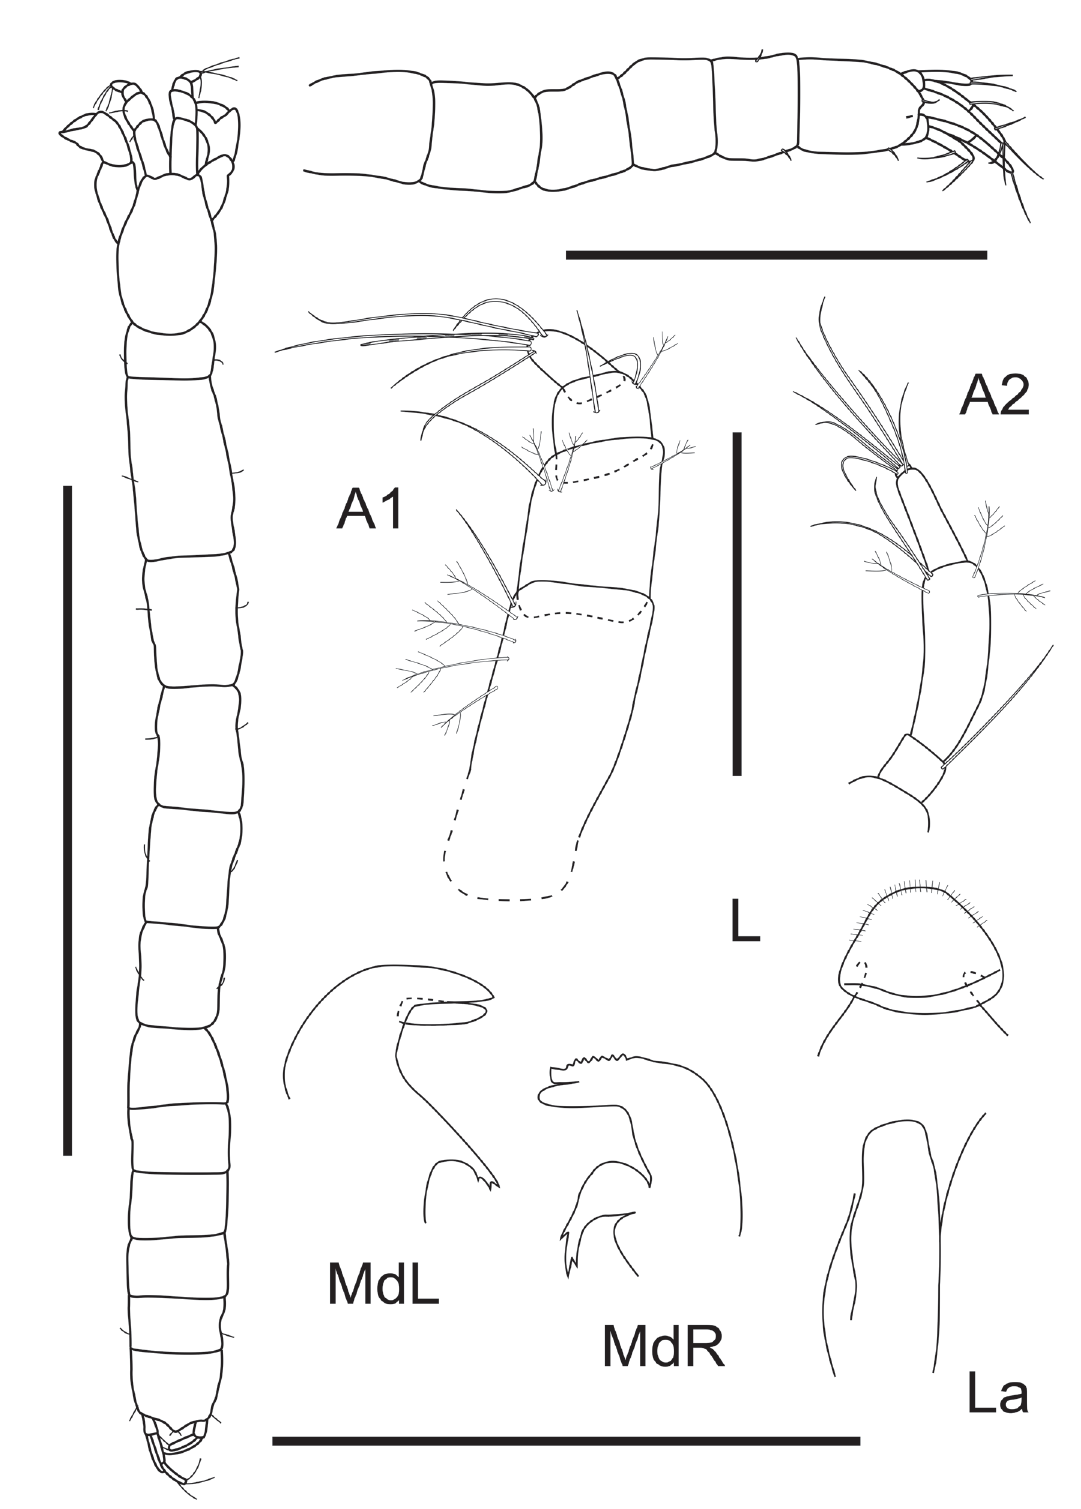
Fig. 2. Filitanais elongatus sp. nov., holotype, ♀ (MNRJ 24443), length 1.9 mm, body in dorsal view. Scale bar = 1.0 mm. Pleon lateral view, scale bar = 0.5 mm. Abbreviations: A1 = antennules; A2 = antenna; L = labrum; MdL = left mandible; MdR = right mandible; La = labium. Scale bars = 0.1